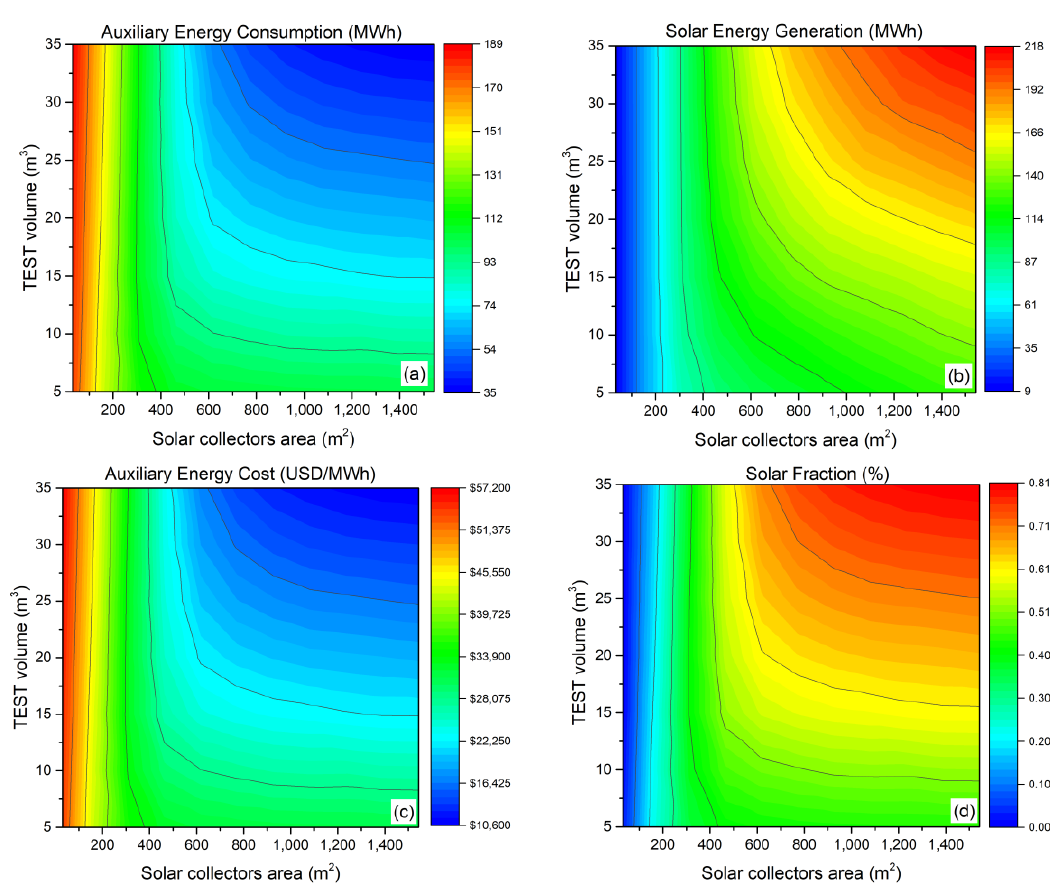
Figure 4. Effect of total solar collector area and total volume of the TEST on ( a ) auxiliary energy consumption, ( b ) solar energy generation, ( c ) auxiliary energy cost, and ( d ) solar fraction. A fuel cost of $1.15 USD / L and an equivalence of 1 L = 3.79 kWh were considered, considering a conversion efficiency of 38%.